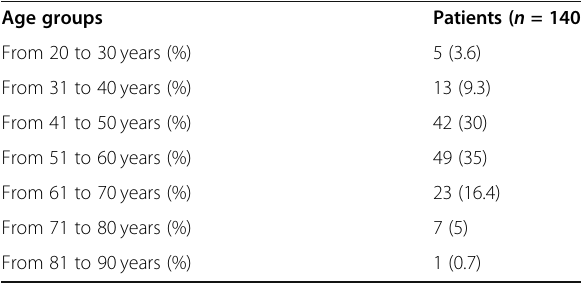
Table 1 Age distribution in STEMI patients Age